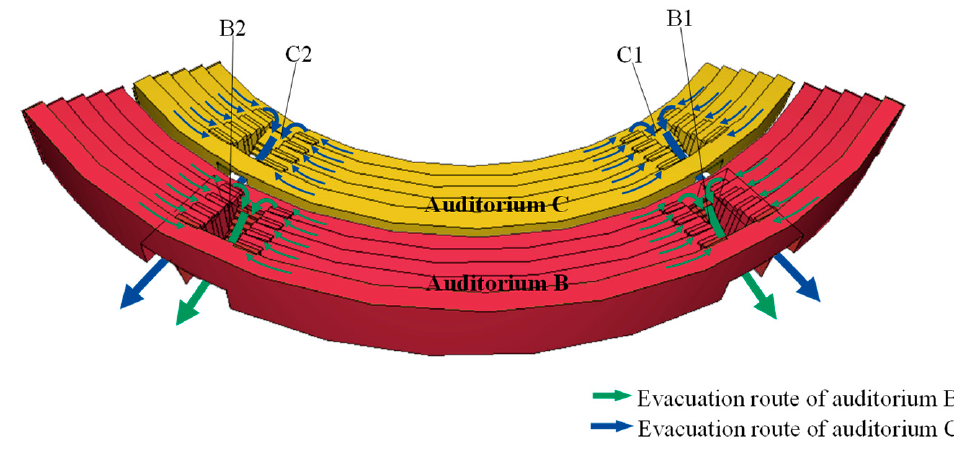
Figure 3. Evacuation routes for auditorium B and auditorium C.